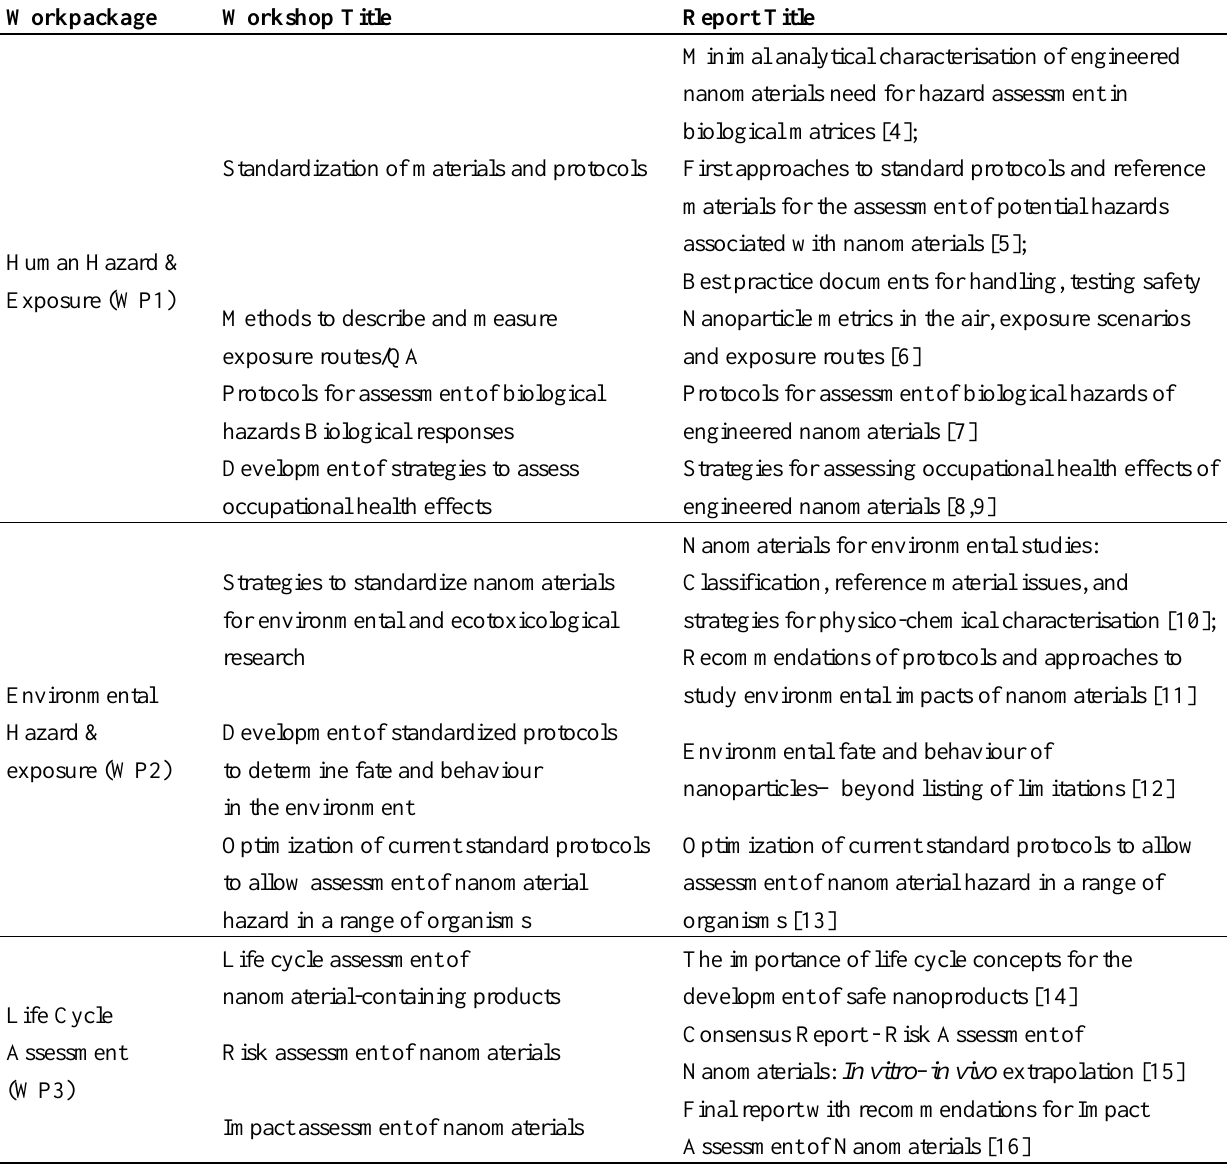
Table 1. Summary of the NanoImpactNet Workshops and resulting